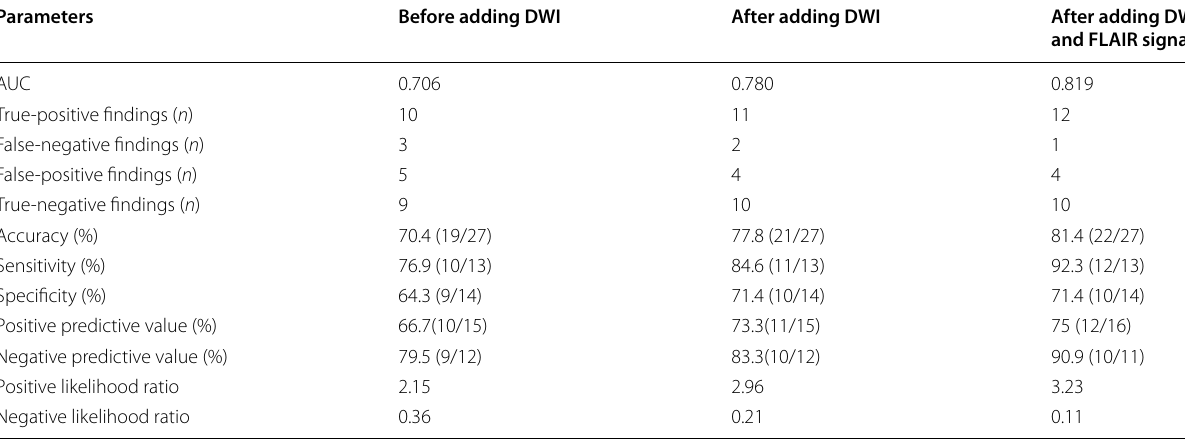
Table 4 Diagnostic performance of BT-RADS category 3 before and after addition of DWI and FLAIR signal within resection cavity